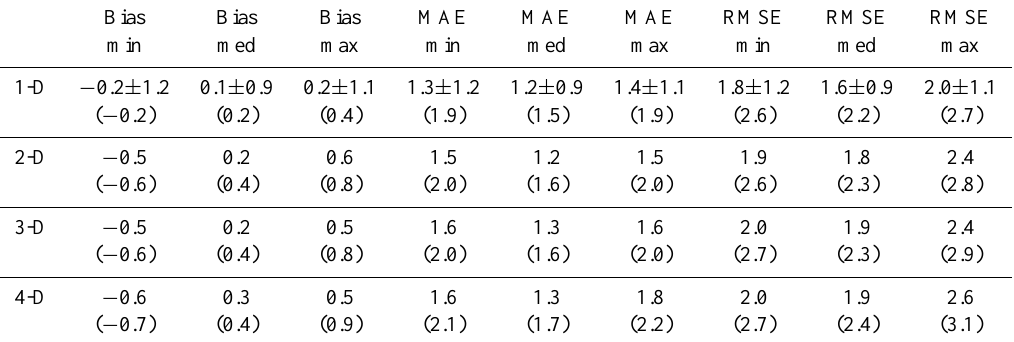
Table 2. Bias, MAE, and RMSE, computed with respect to the OI analyses, averaged for land grid points. Rows show the result for each forecast day. Min, med, and max refers to minimum, mean and maximum temperature, respectively. The analysis error is shown only for the first day and is equal for all days. Values into parentheses show the statistics computed with respect to SI